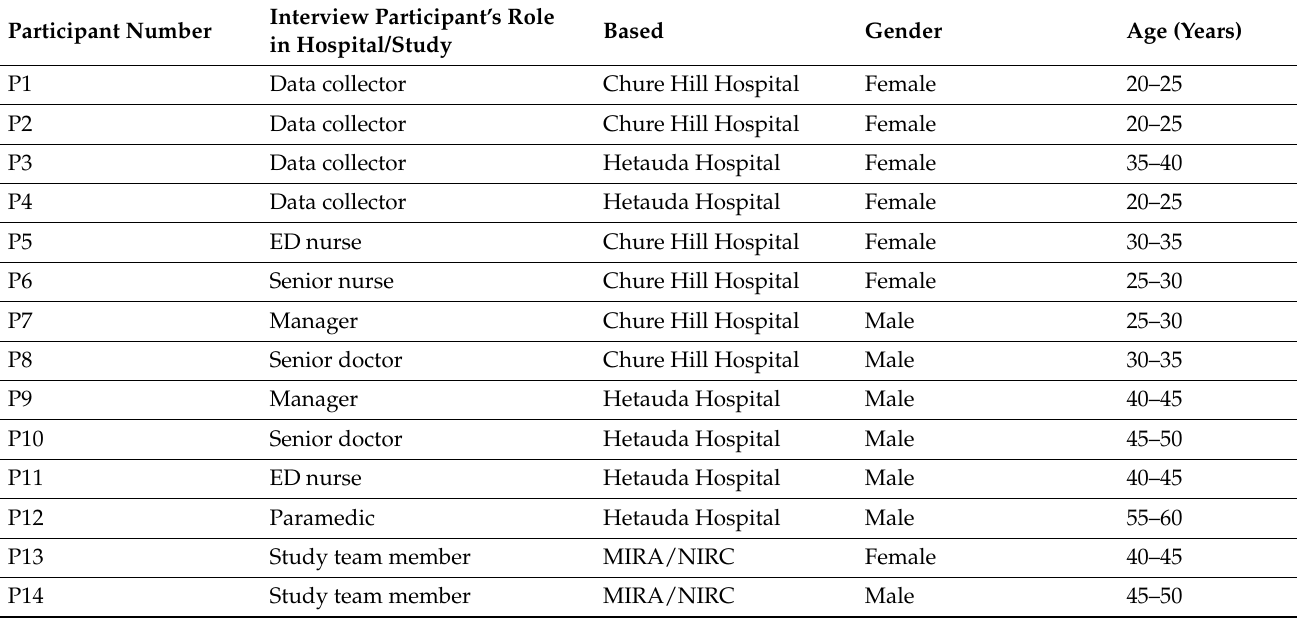
Table 4. Interview participants’